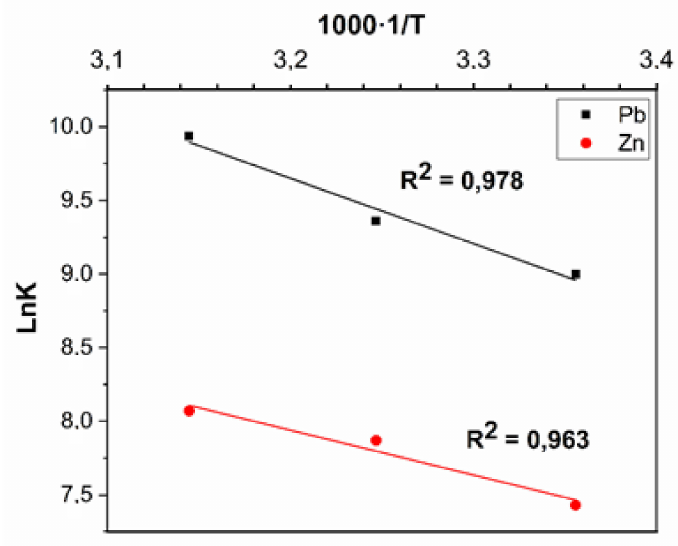
Figure 14. Dependence graph of lnK versus reciprocal temperature.